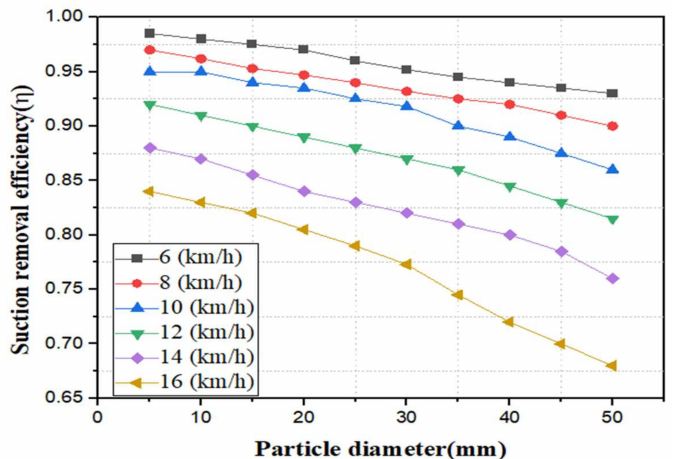
Figure 12. The results of experimental effect of conveyor belt speed on collection